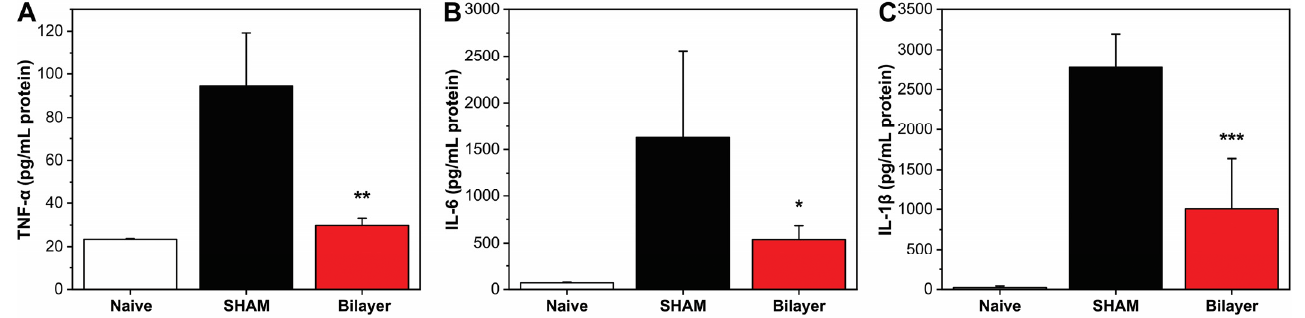
Figure 4. In vivo evaluation of TNF- α ( A ), IL-6 ( B ), and IL-1 β ( C ) after 48 h from wound induction. * p < 0.05 vs. the wound untreated group; ** p < 0.01 vs. the wound untreated group; *** p < 0.001 vs. the wound untreated group.